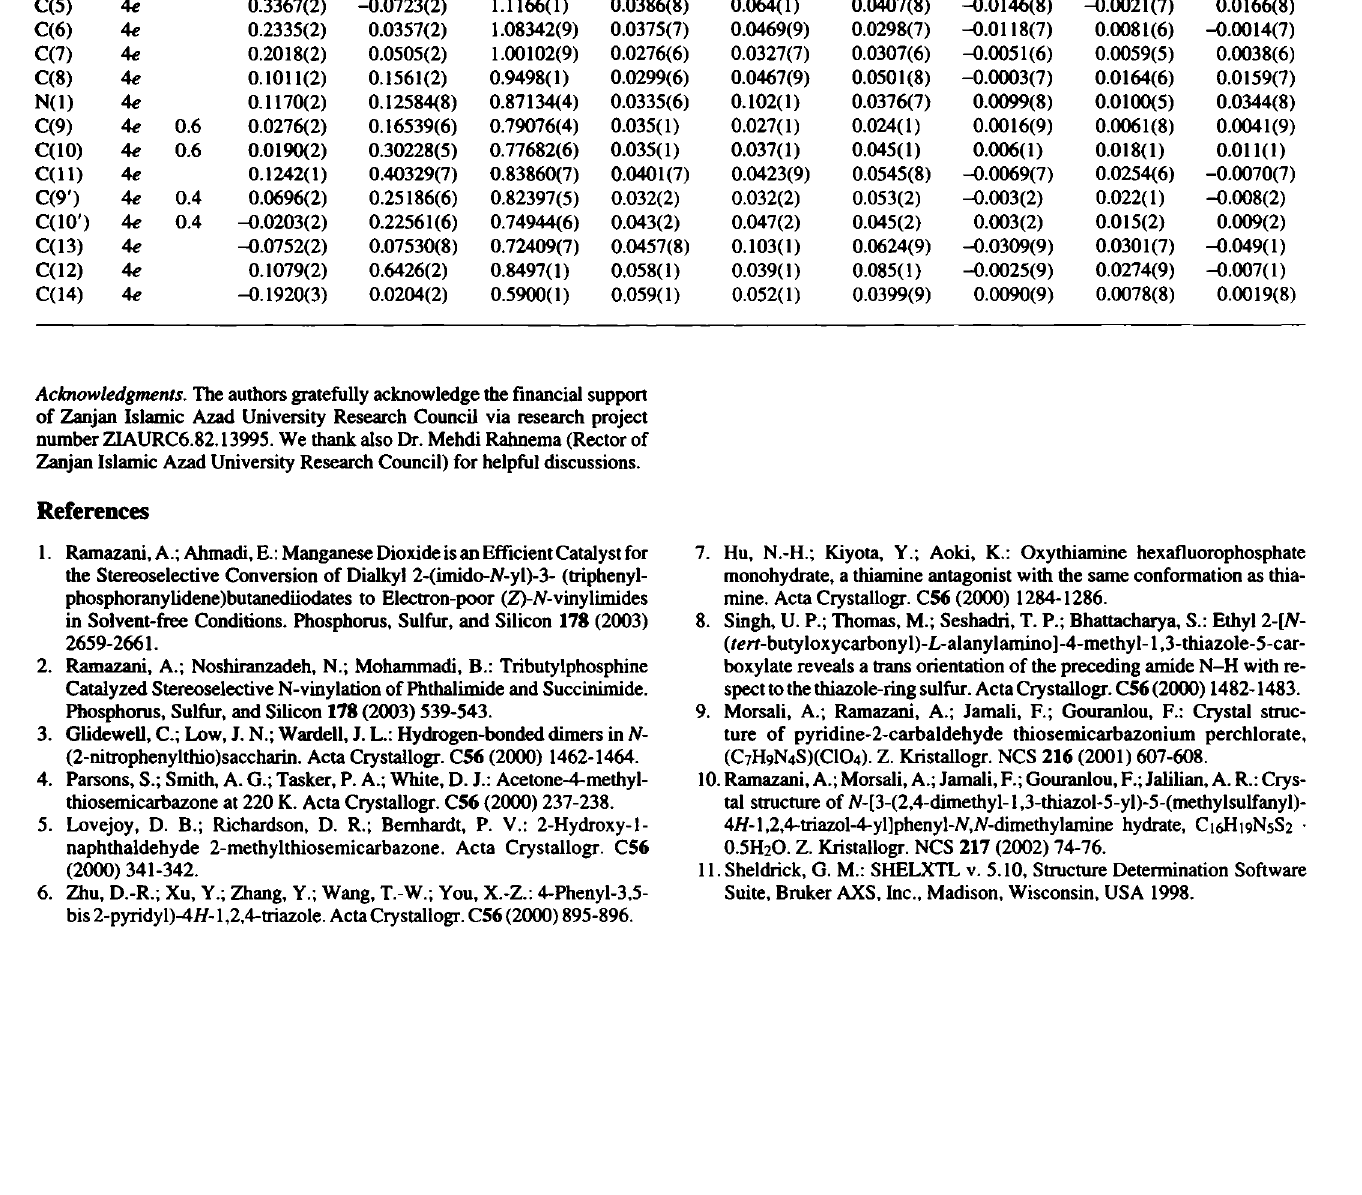
Table 3. Atomic coordinates and displacement parameters (in A 2